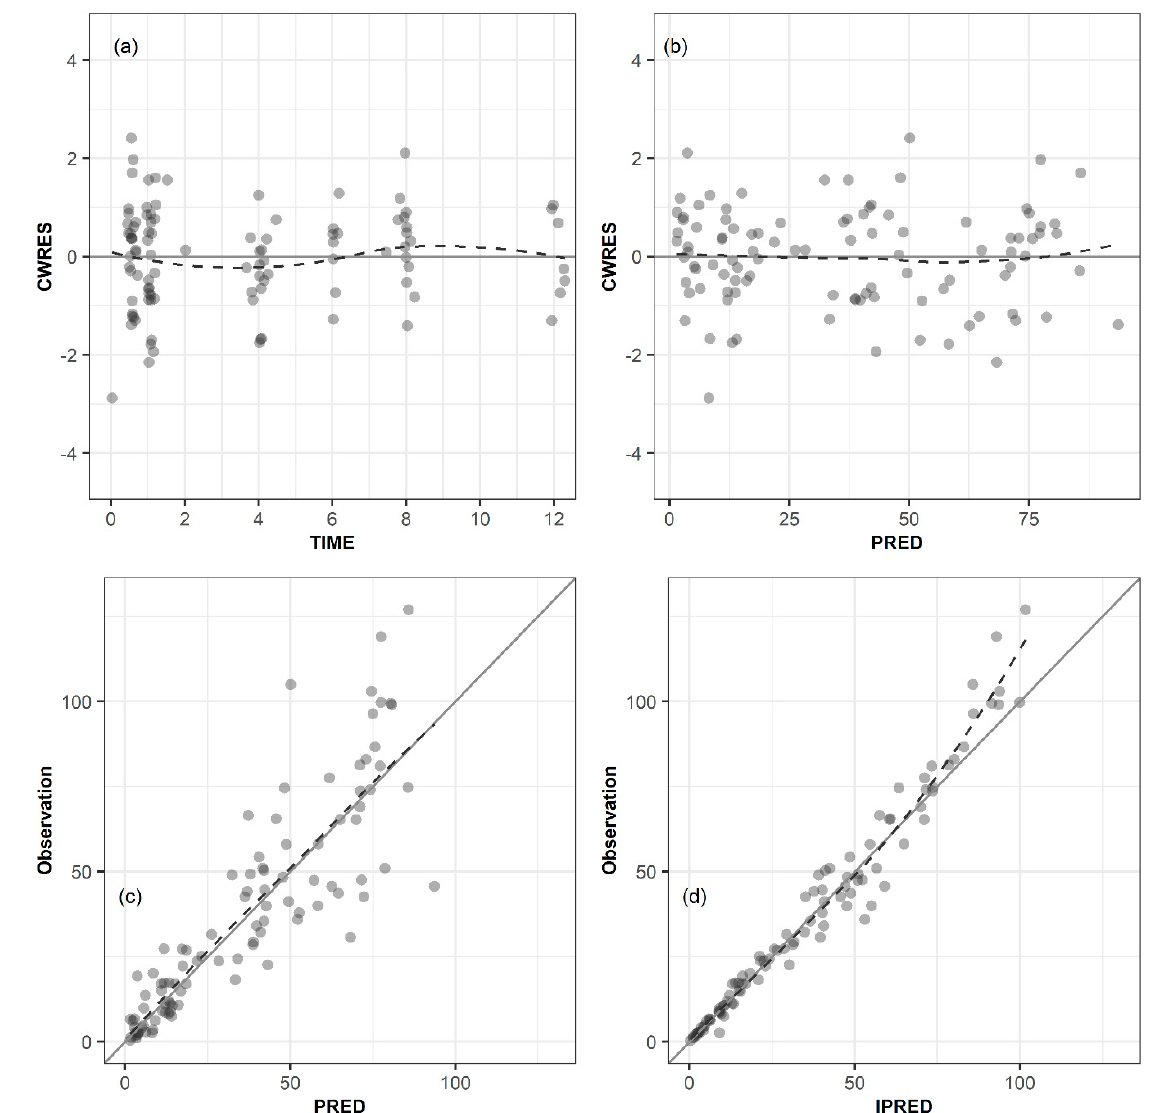
Figure 1. Goodness–of–fit plots. ( a ) Conditional weighted residuals (CWRES) versus time, ( b ) CWRES versus population predicted concentration (PRED), ( c ) observed concentration versus PRED, and ( d ) observed concentration versus individual predicted concentration. The dashed lines indicate smooth curves.